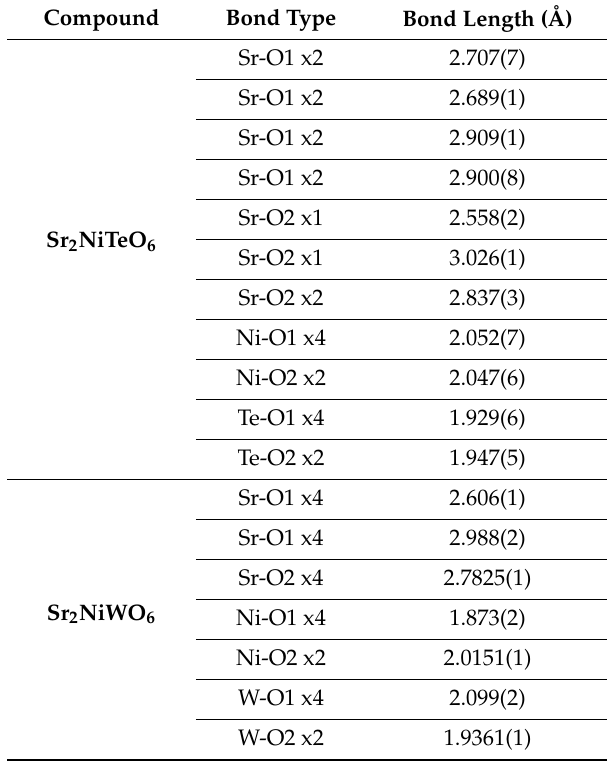
Table 4. Selected interatomic distances for synthesized compounds.